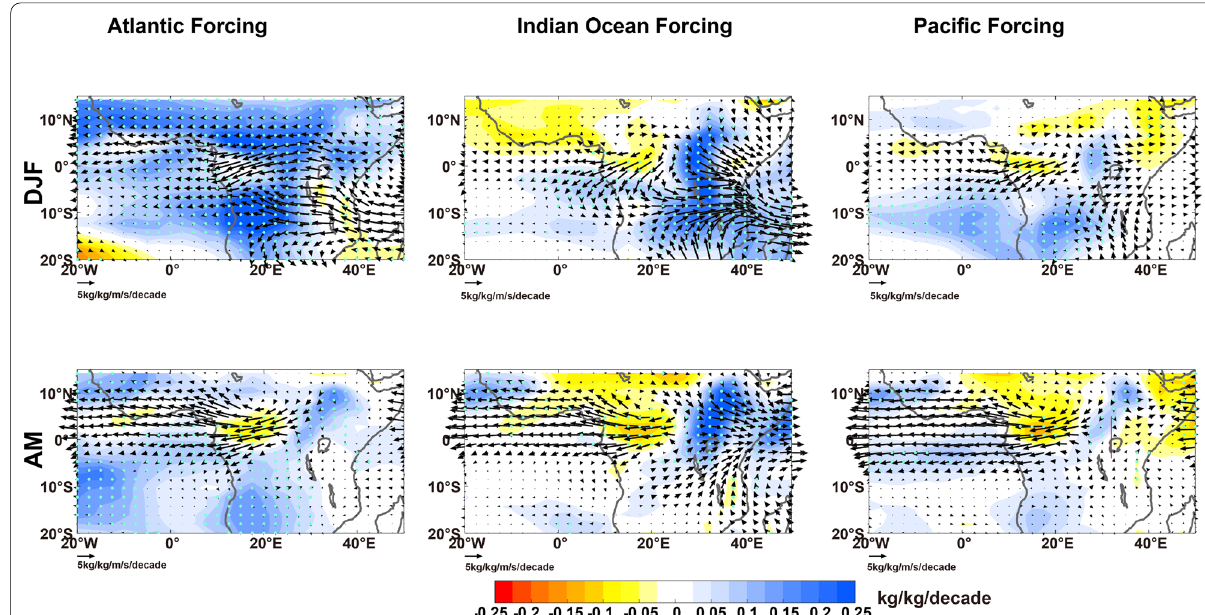
Fig. 8 Simulated seasonal change of moisture and moisture flux at 825 hPa in Atmospheric Models. Color mapping illustrates the special humidity change (increase, blue color; decreased, yellow color) and the vector illustrates the moisture flux change. Green dots indicate that special humidity change is significant at the 5% level. a – c show the change forced by the tropical Atlantic, Indian Ocean and Pacific during the boreal winter dry season (DJF). d – f same as a – c but for the boreal spring wet season